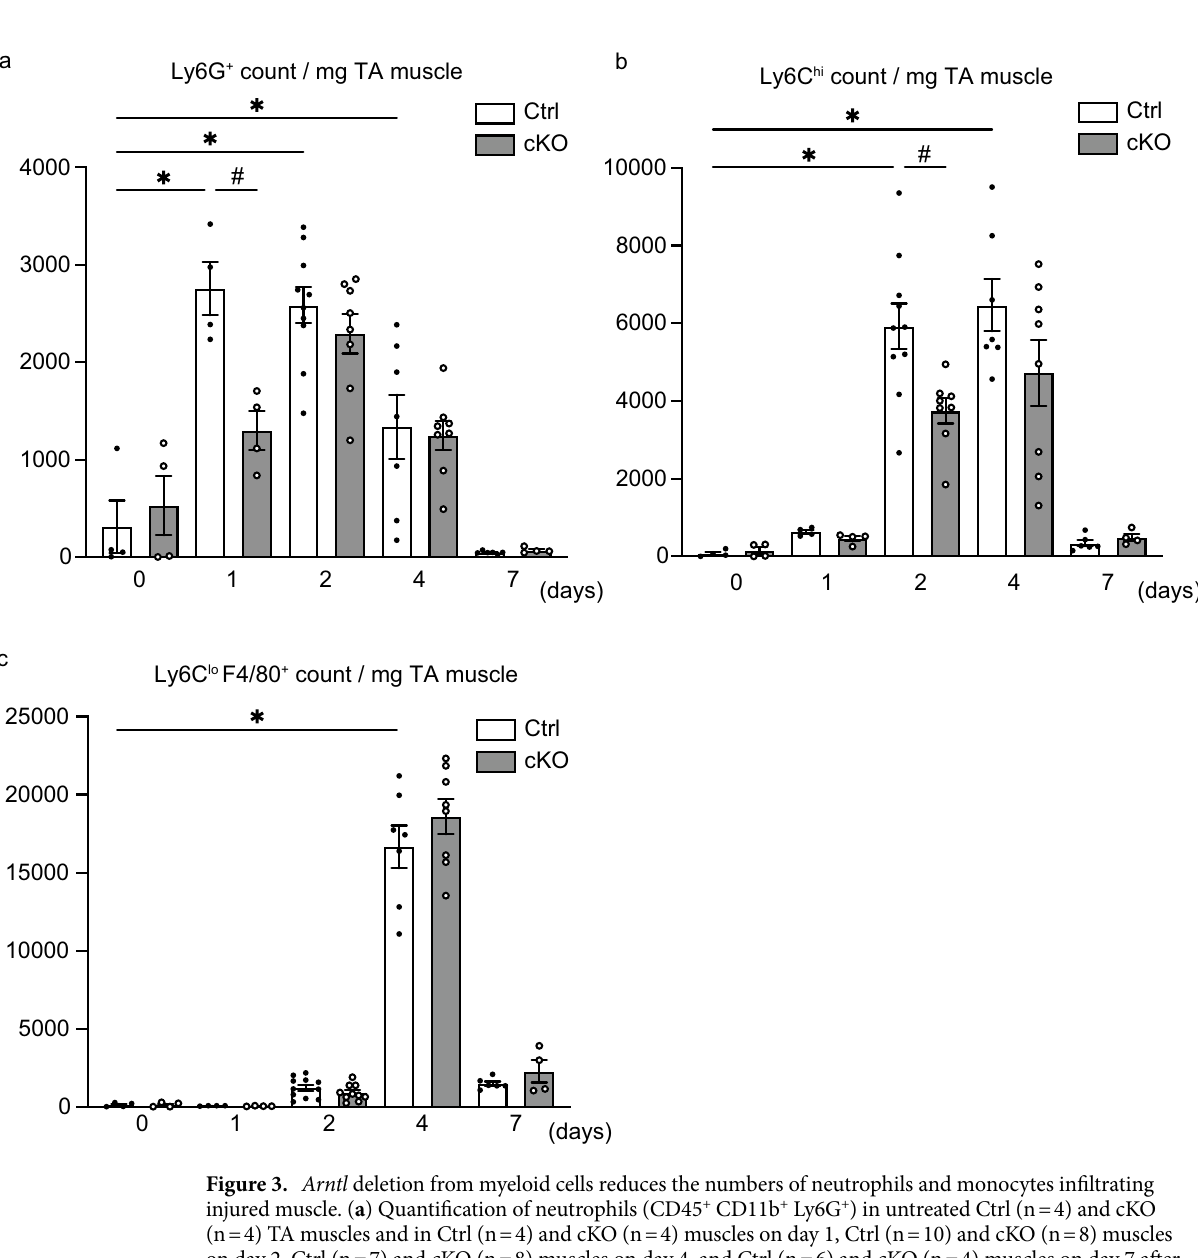
Figure 3. Arntl deletion from myeloid cells reduces the numbers of neutrophils and monocytes infiltrating injured muscle. ( a ) Quantification of neutrophils (CD45 + CD11b + Ly6G + ) in untreated Ctrl (n = 4) and cKO (n = 4) TA muscles and in Ctrl (n = 4) and cKO (n = 4) muscles on day 1, Ctrl (n = 10) and cKO (n = 8) muscles on day 2, Ctrl (n = 7) and cKO (n = 8) muscles on day 4, and Ctrl (n = 6) and cKO (n = 4) muscles on day 7 after CTX injury. ( b ) Quantification of monocytes (CD45 + CD11b + Ly6G - Ly6C hi ) in untreated Ctrl (n = 4) and cKO (n = 4) TA muscles and in Ctrl (n = 4) and cKO (n = 4) muscles on day 1, Ctrl (n = 10) and cKO (n = 8) muscles on day 2, Ctrl (n = 7) and cKO (n = 8) muscles on day 4, and Ctrl (n = 6) and cKO (n = 4) muscles on day 7 after CTX injury. ( c ) Quantification of macrophages (CD45 + CD11b + Ly6G - Ly6C lo ) in untreated Ctrl (n = 4) and cKO (n = 4) TA muscles and in Ctrl (n = 4) and cKO (n = 4) muscles on day 1, Ctrl (n = 10) and cKO (n = 8) muscles on day 2, Ctrl (n = 7) and cKO (n = 8) muscles on day 4, and Ctrl (n = 6) and cKO (n = 4) muscles on day 7 after CTX injury. Data are expressed as the means ± SEM. * p < 0.05 vs. untreated Ctrl muscles, # p < 0.05 vs. Ctrl muscles per day with two-way ANOVA with Bonferroni’s multiple comparisons